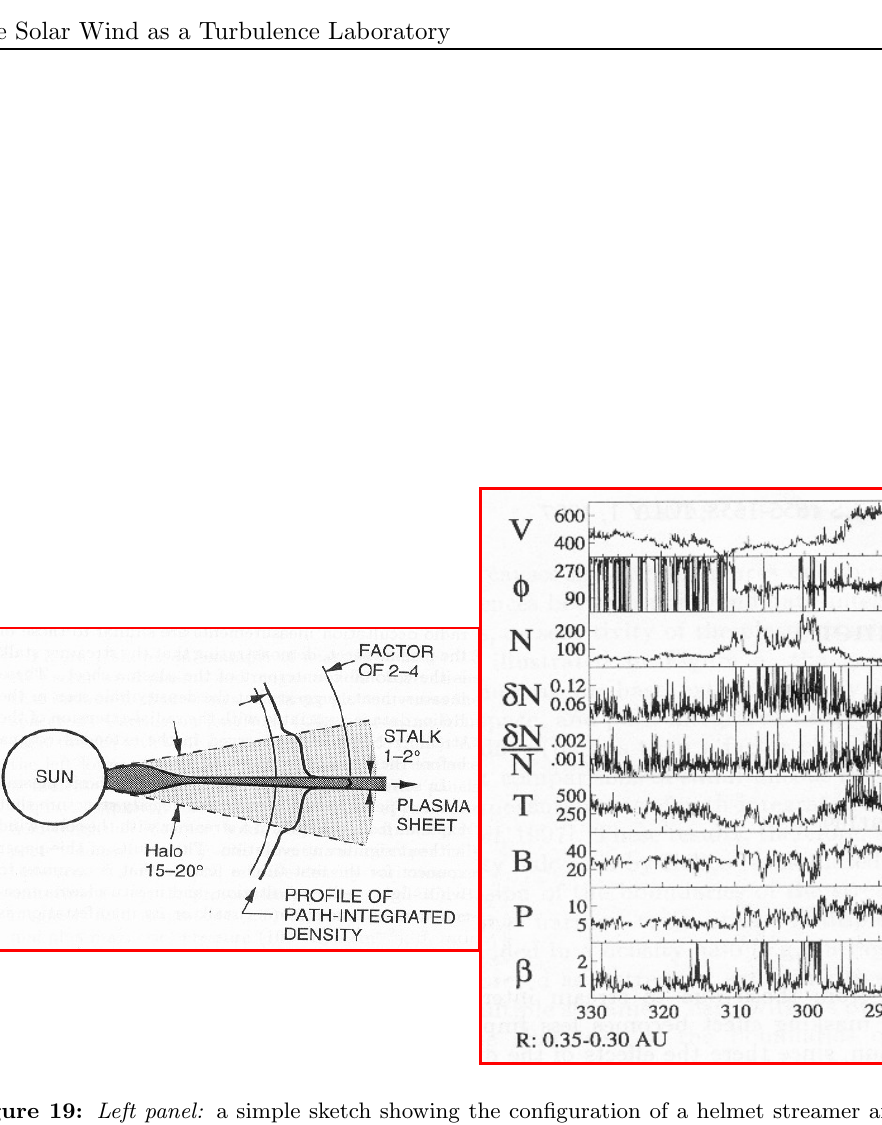
Figure 19: Left panel: a simple sketch showing the configuration of a helmet streamer and the density profile across this structure. Right panel: Helios 2 observations of magnetic field and plasma parameters across the heliospheric current sheet. From top to bottom: wind speed, magnetic field azimuthal angle, proton number density, density fluctuations and normalized density fluctuations, proton temperature, magnetic field magnitude, total pressure, and plasma beta, respectively. Image reproduced by permission from Bavassano et al. (1997), copyright by